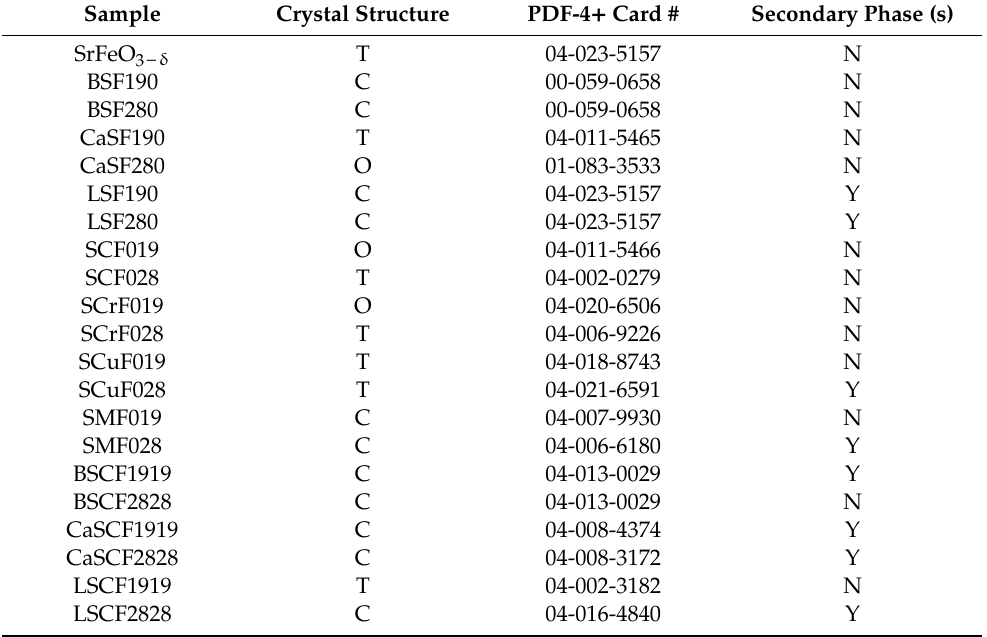
Table 1. Lattice structures from X-ray di ff ractometry for A- and / or B-site substitutions in SrFeO 3 − δ (C ≡ cubic, T ≡ tetragonal, O ≡ orthorhombic, M ≡ monoclinic) with secondary phase